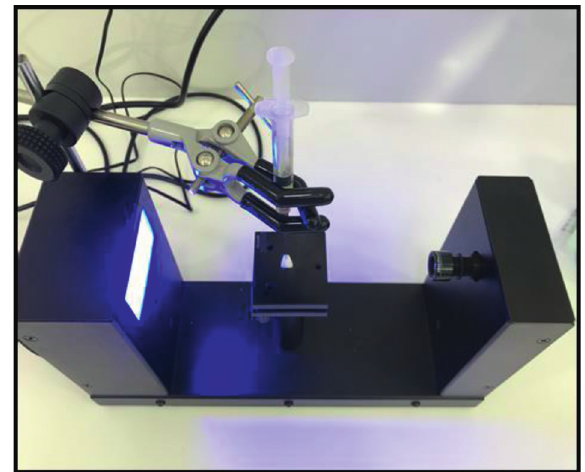
Figure 3: Mounting of enamel disc and bonding agent.